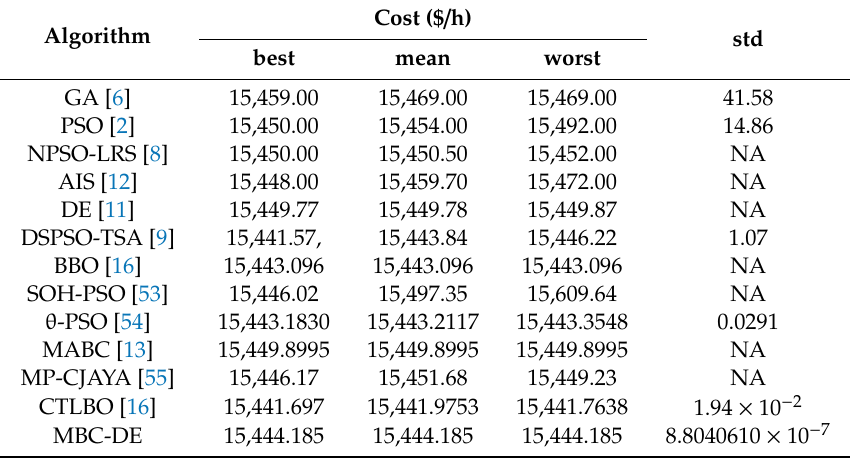
Table 7. Algorithm comparison between MBC_DE and other algorithms for test case 1.